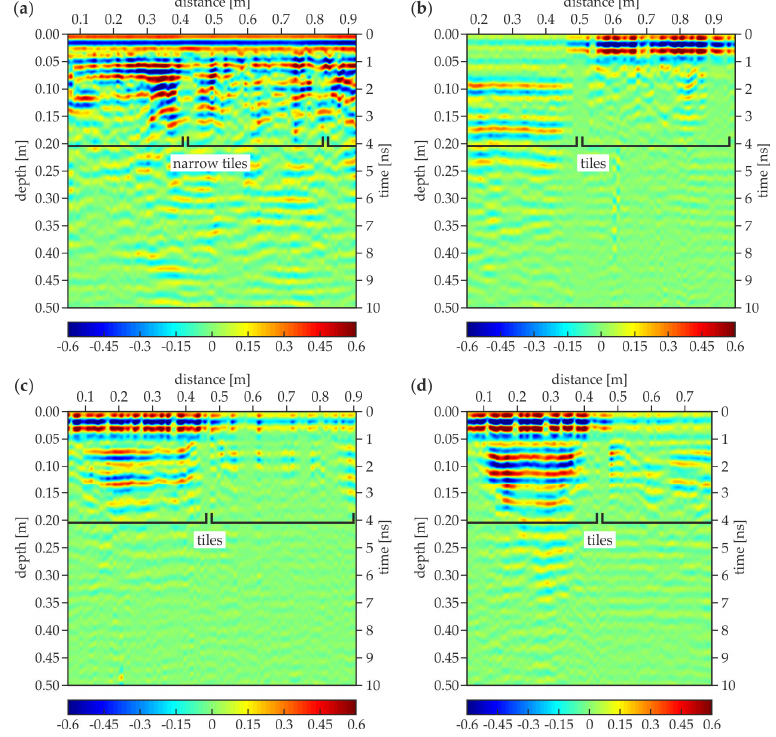
Figure 16. Ultrasonic B ‐ scans for the trial pit: ( a ) edge 1 (trace C ‐ 1); ( b ) edge 2 (trace C ‐ 2); ( c ) edge 3 (trace C ‐ 3); ( d ) edge 4 (trace C ‐